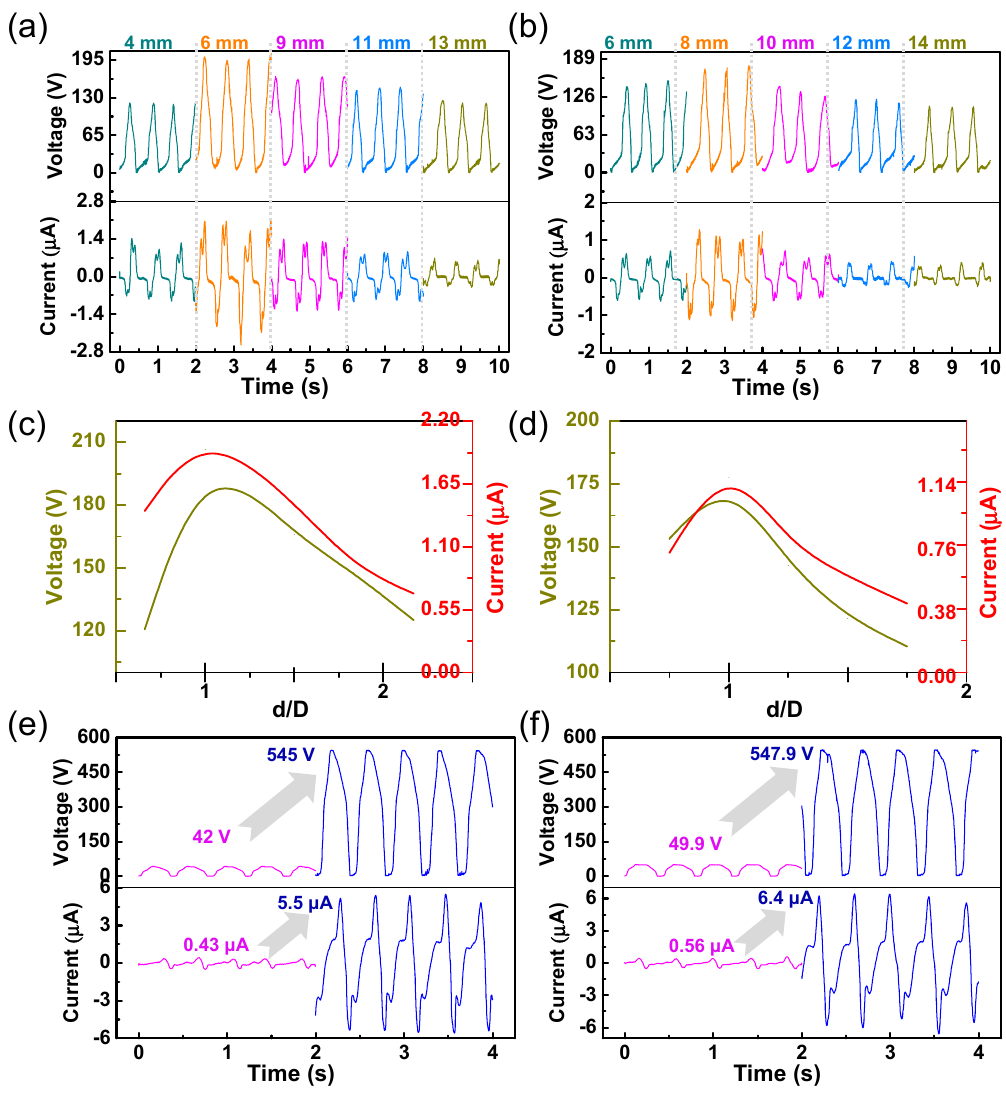
Figure 3. The effects of the coupling electrostatic energy and the relationship between PTFE ball diameter and electrode width on the output of the C − ENG: ( a ) the effect of cross-finger electrode width on the output of the C − ENG at the PTFE ball diameter of 6 mm; ( b ) the effect of cross-finger electrode width on the output of the C − ENG at the PTFE ball diameter of 8 mm; ( c ) a curve fitted according to Figure 3a; ( d ) a curve fitted according to Figure 3b; ( e ) a comparison of output characteristics between W − TENG and C − ENG at the PTFE ball diameter of 6 mm; and ( f ) a comparison of output characteristics between W − TENG and C − ENG at the PTFE ball diameter of 8 mm.